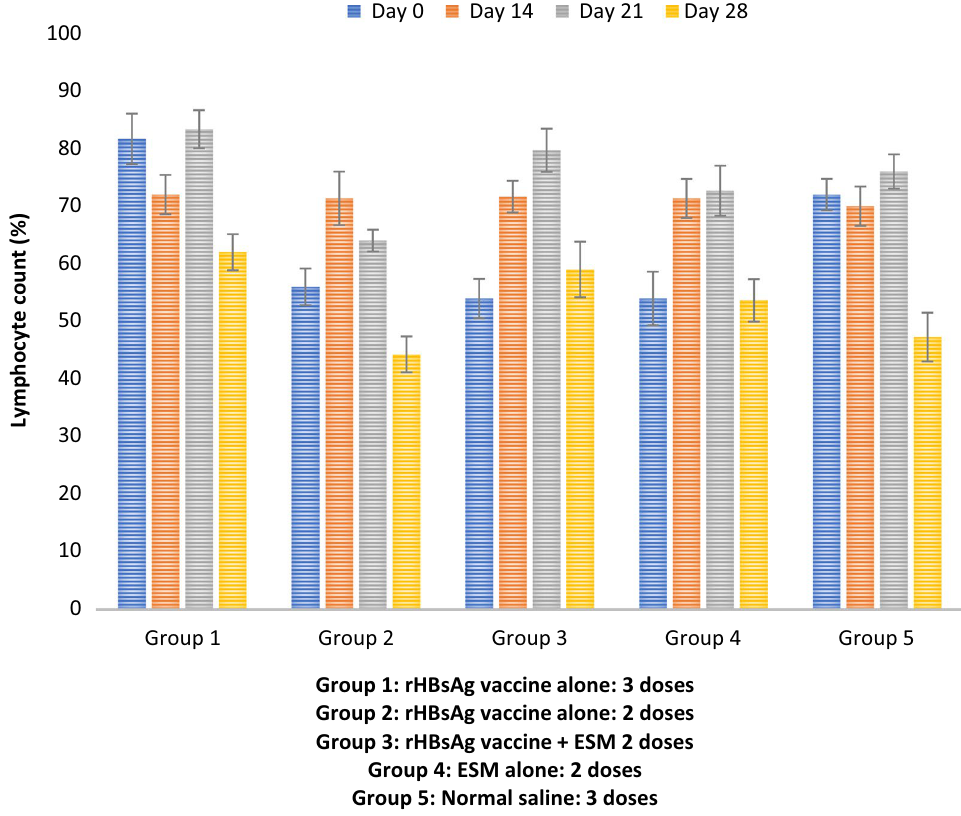
Fig. 2 Percentage lymphocyte population from differential WBC analysis across experimental